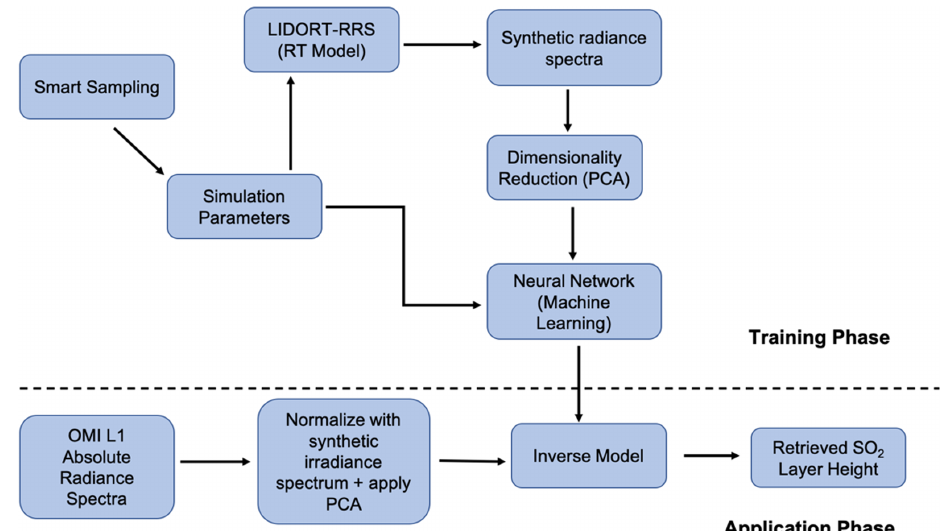
Figure 1. The flowchart of the FP_ILM methodology for retrieving OMI SO 2 effective layer height. The steps above the dashed line are part of the training phase done prior to incorporation of OMI measurements. The application phase involves deployment of the trained model to the OMI radiance measurements to obtain estimates of effective volcanic SO 2 layer heights.